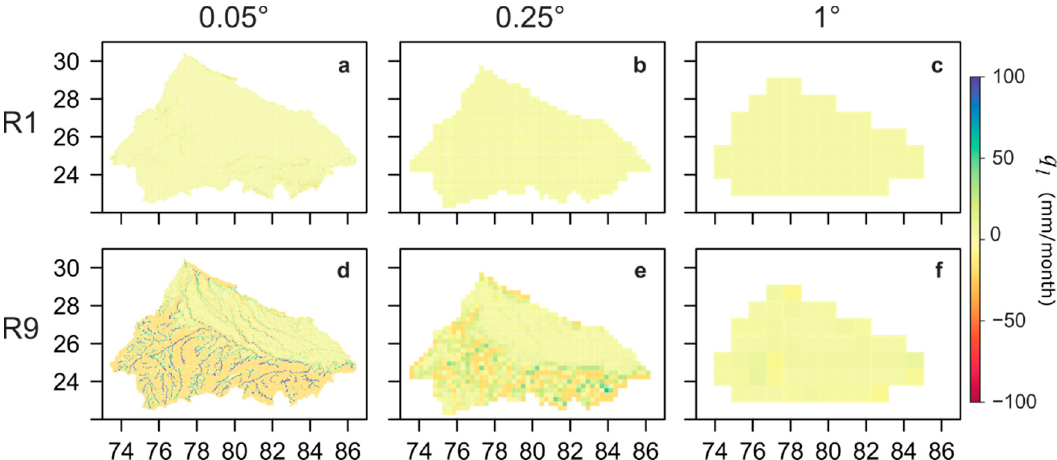
Figure 8. Cell-mean lateral groundwater flow for R1 and R9 and three different grid resolutions. Table 3. Mean WTD, recharge, ET, runoff and lateral groundwater flow for three runs and the three grid resolutions.